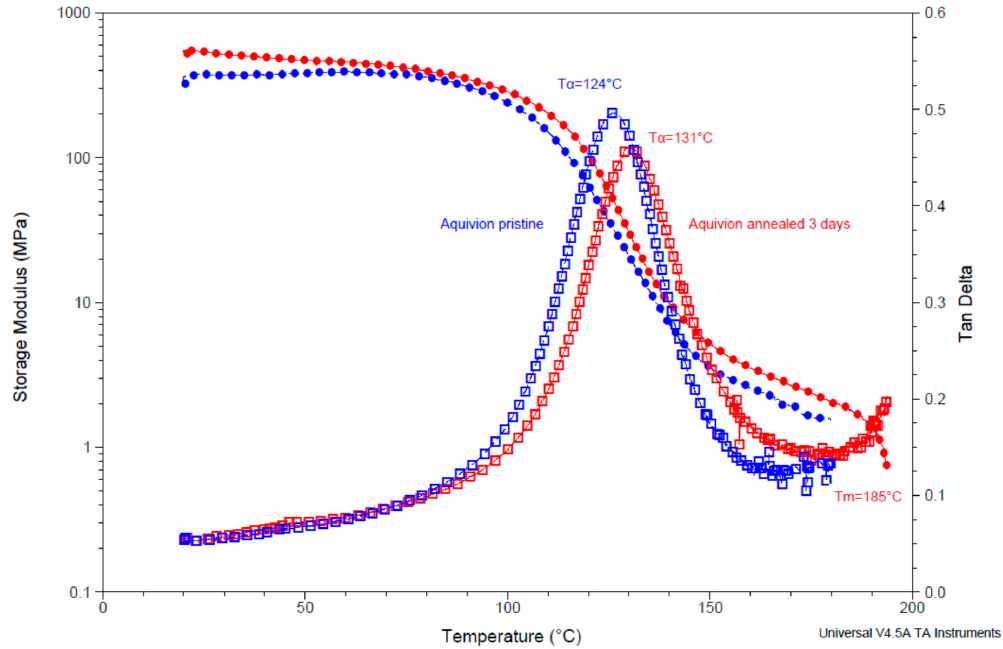
Figure 6. Dynamic mechanical analysis (DMA) curves of Aquivion ® 870 before ( blue ) and after annealing at 140 °C in presence of DMSO for 3 days ( red ). Table 1. Ionomer relaxation temperatures T α (°C), maximum damping intensity I (tan δ ) and storage